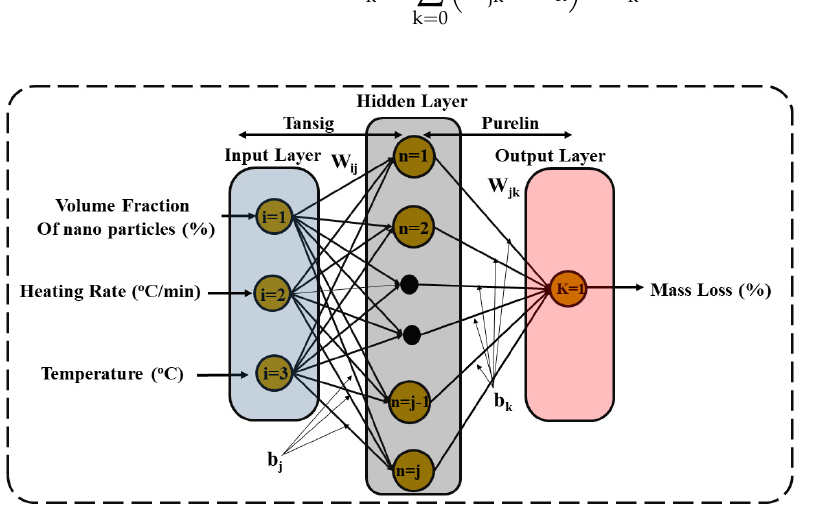
Figure 3. The basic structure of an artificial neural network.